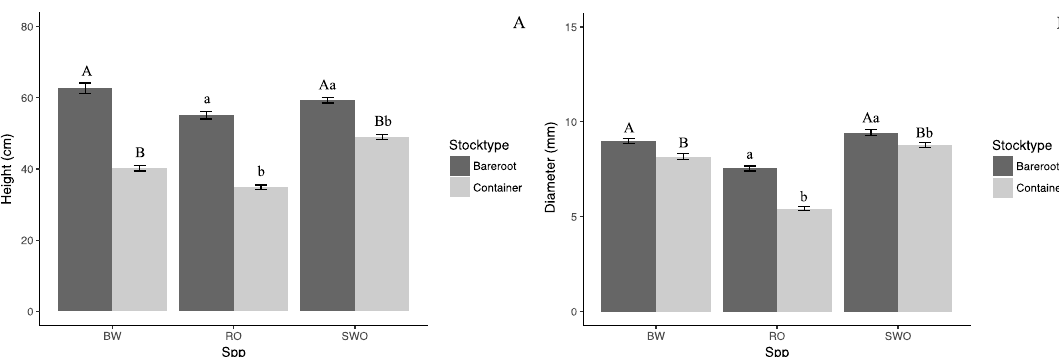
Figure 4. Second year absolute height ( A ) and diameter ( B ) for black walnut (BW), red oak (RO), and swamp white oak (SWO) by stocktype. Columns are means, and error bars are ( ± SE). Species were analyzed separately. Columns with di ff erent letters are statistically di ff erent according to Tukey’s Honestly Significant Di ff erence (HSD) test at α =